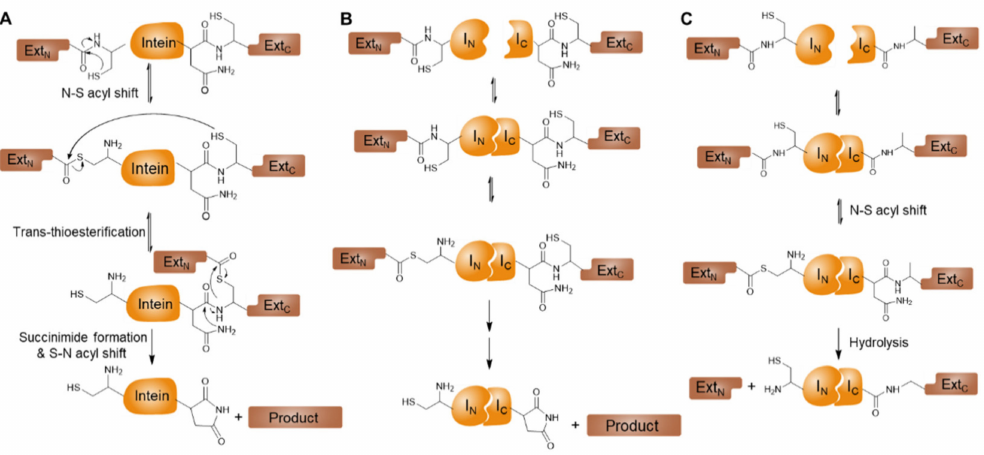
Figure 2. Curved arrow mechanisms of intein-mediated reactions. ( A ) Intein-mediated protein splicing. ( B ) Split-intein-mediated protein trans-splicing. ( C ) Split-intein-mediated protein trans- cleavage. Reproduced with permission from BioChip J. 2016 , 10 , 277–287